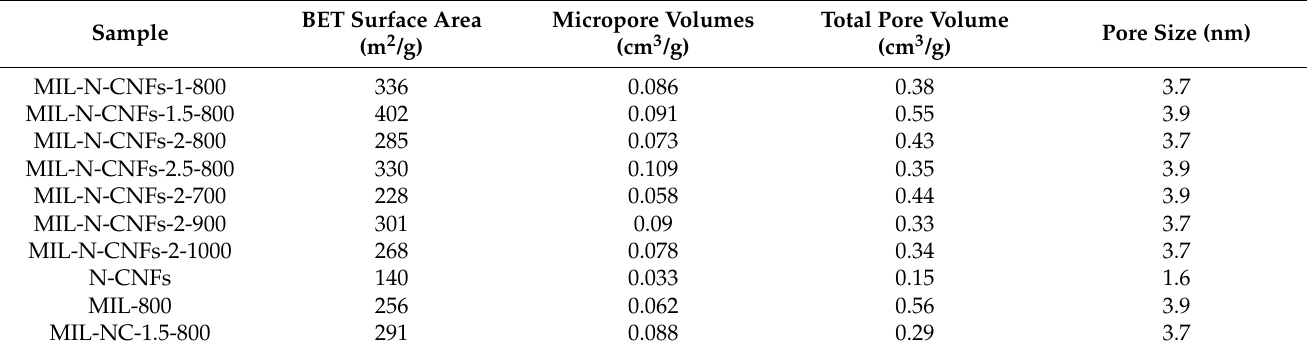
Table 1. Surface areas, pore volume distribution and pore size of MIL-N-CNFs-x-T catalysts, N-CNFs, MIL-800 and